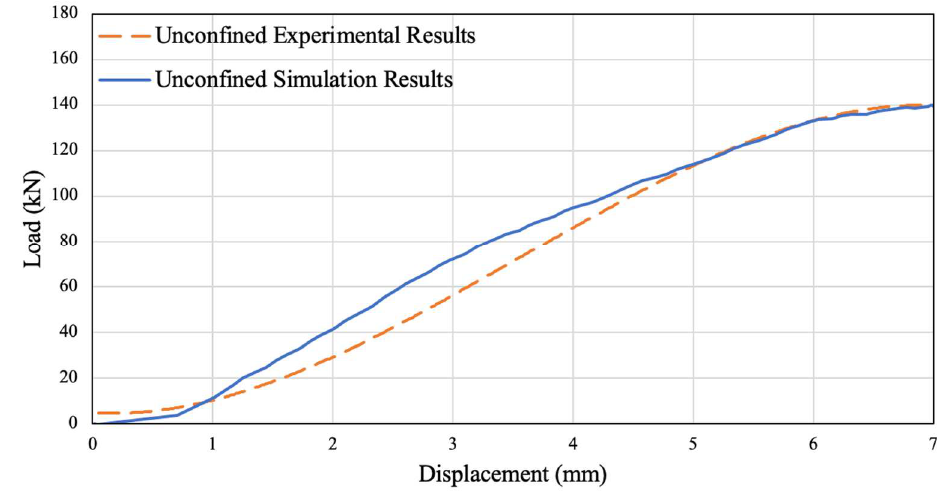
Figure 15. Unconfined Simulation and Experimental Results Comparison.